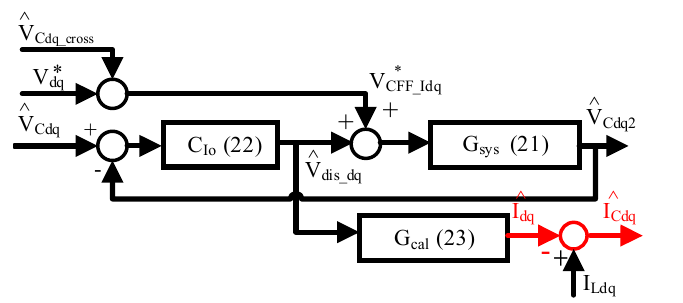
Figure 6. Proposed second observer in Figure 2 for capacitor current estimation and machine current estimation.